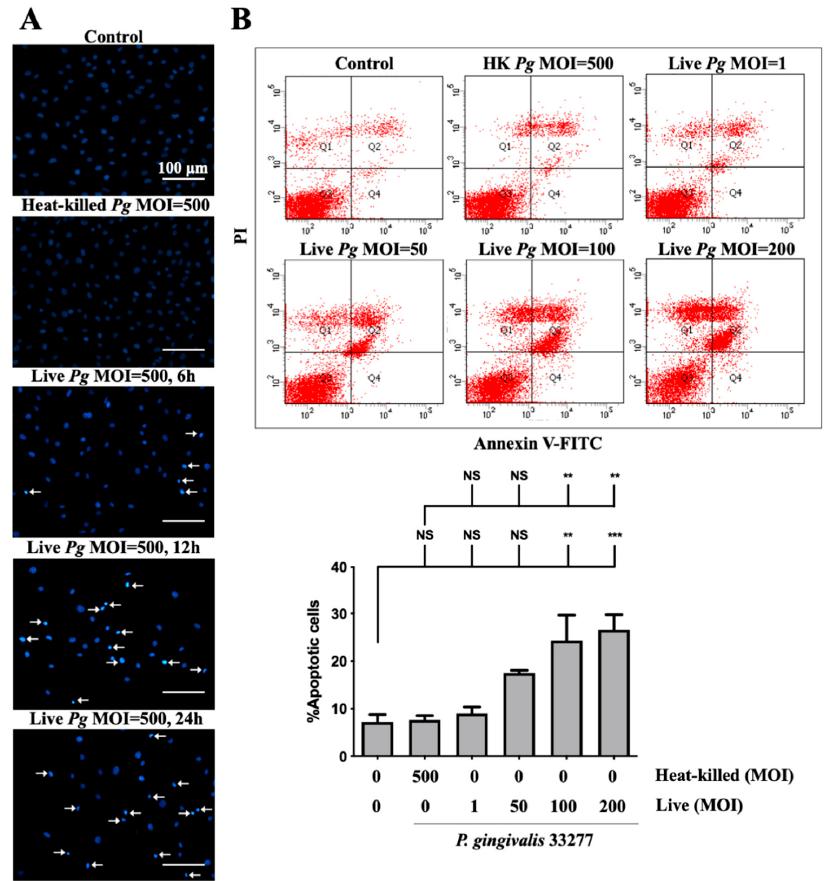
Figure 3. P. gingivalis infection induces cell apoptosis in bEnd.3 brain endothelial cells. ( A ) Cells are infected with either heat-killed or live P. gingivalis at an MOI of 500 for 90 min. After being replaced with fresh medium for 6, 12, or 24 h, nuclear condensation is determined by DAPI staining. Arrows indicate cells with a condensed nucleus. The scale bar represents 100 µ m. ( B ) Cells are treated with various live bacteria (1, 50, 100 and 200 MOI) or heat-killed bacteria (500 MOI) for 90 min. Cell survival is stained with Annexin V FITC/PI after 24 h and analyzed with a flow cytometer (upper panel). The quantitative percentage of apoptotic cells is shown in the lower panel. Data are presented as mean values ± SEM ( n = 4). Significant differences of the control or heat-killed P. gingivalis group are expressed as **, p < 0.01; ***, p < 0.001; NS, p > 0.05.